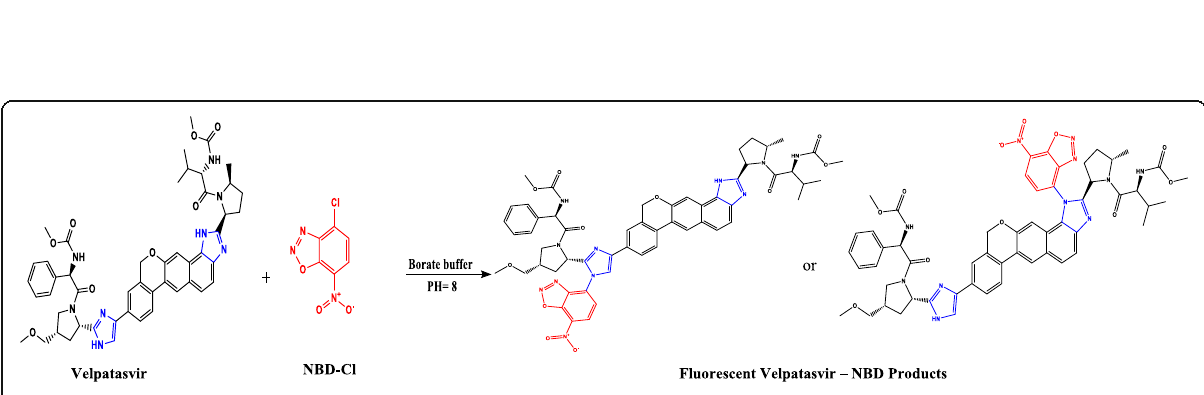
Scheme 1 Proposed reaction pathway of VP and